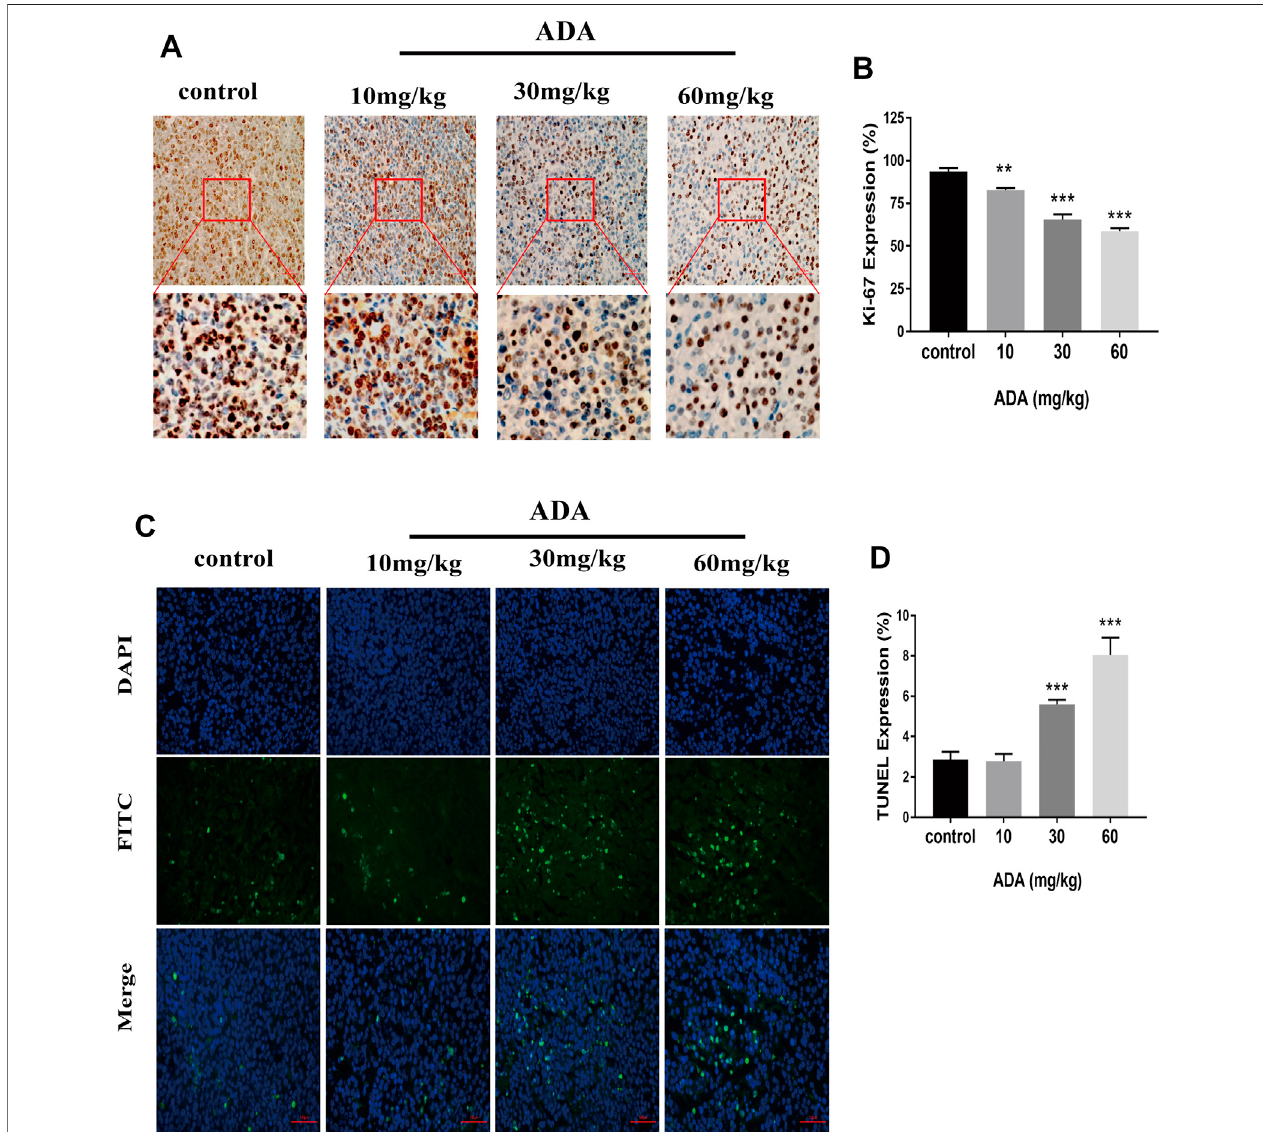
FIGURE 7 | ADA inhibited the Ki-67 expression and promotes the apoptosis of RM-1 prostate cancer cells in tumor tissues. (A) The expression of Ki-67 was analyzed by immunohistochemistry (IHC) staining (200×). (B) Histograms showing quantitative Ki-67 expression analyses. (C) The RM-1 cells were stained by TUNEL staining (400×). (D) Histograms showing the quantitative percentage of TUNEL-positive cells. Data are presented as mean ± standard deviation. (* p < 0.05; ** p < 0.01; *** p < 0.001 vs. control).